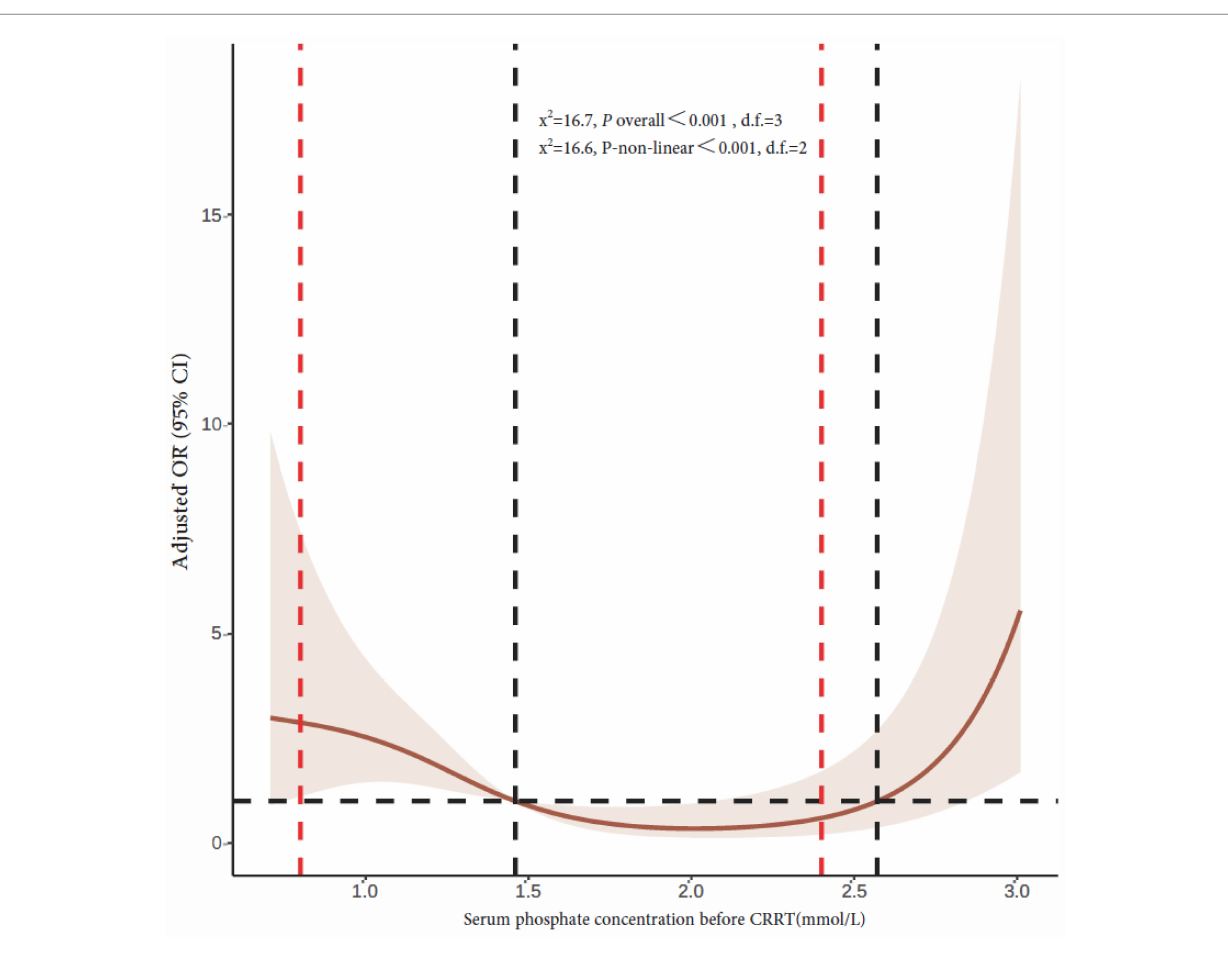
ICUs, and patients in the hyperphosphatemia group had higher serum creatinine concentrations and lower glomerular fi ltration rates. However, in our study, patients were predominantly from the PICU, and there was no signi fi cant difference in the creatinine concentration before CRRT initiation between groups with different serum phosphate concentration ranges. The different sources of patients may explain the varied distribution